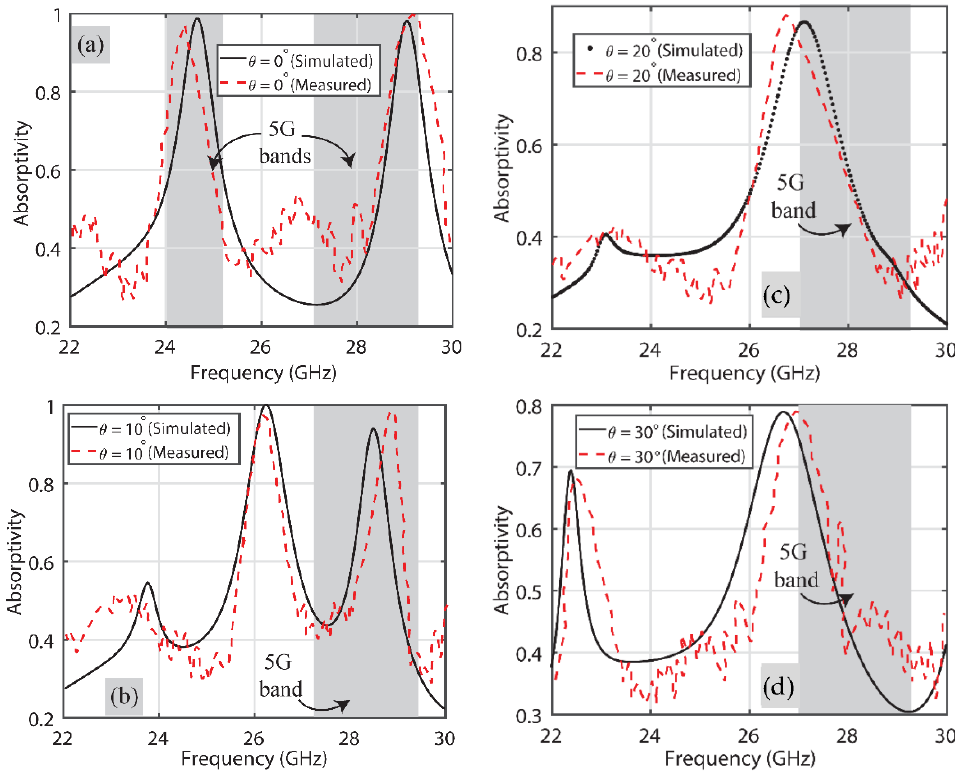
Figure 11. Performance comparison of the proposed MA for TM polarization at ( a ) 0°, ( b ) 10°, ( c ) 20° and ( d ) 30°.